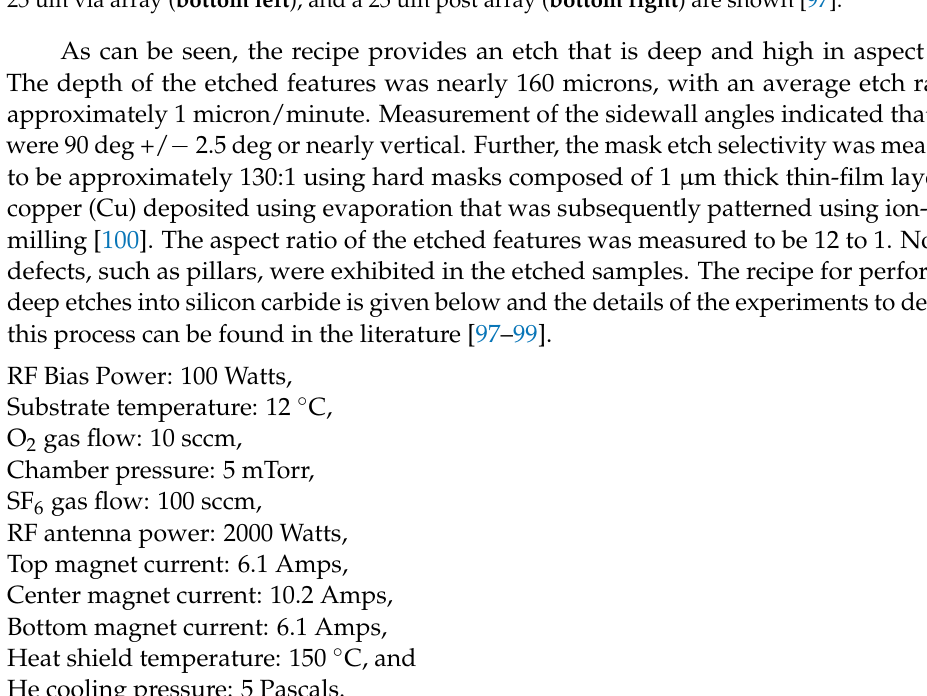
Figure 9. Scanning electron microscope (SEM) images of array of vias and posts after performing plasma etch using ULVAC NLD-6000. A 50 um via array ( top left ), a 25 um post array ( top right ), a 25 um via array ( bottom left ), and a 25 um post array ( bottom right ) are shown